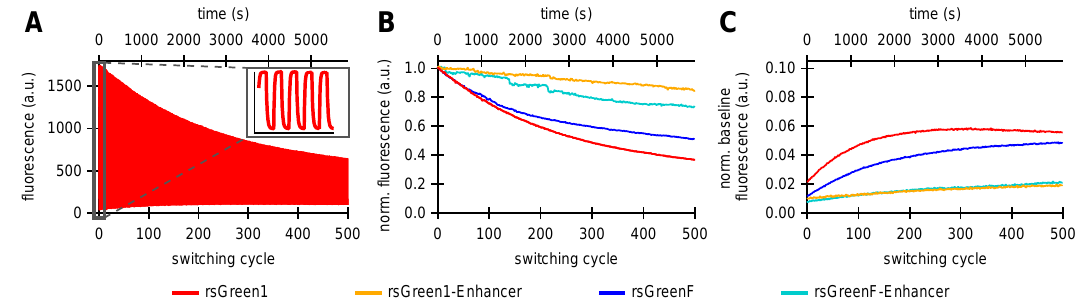
Figure 4. The effect of Enhancer nanobody binding on the repeated photoswitching behavior of rsGreens in HeLa cells (500 cycles): ( A ) representative fluorescence photoswitching trace of rsGreen1, inset shows the initial five switching cycles; ( B ) signal of the maximally on-switched frame for each switching cycle scaled to the initial on-state fluorescence; and ( C ) baseline fluorescence (maximally off-switched frame) as fraction of the initial on-state